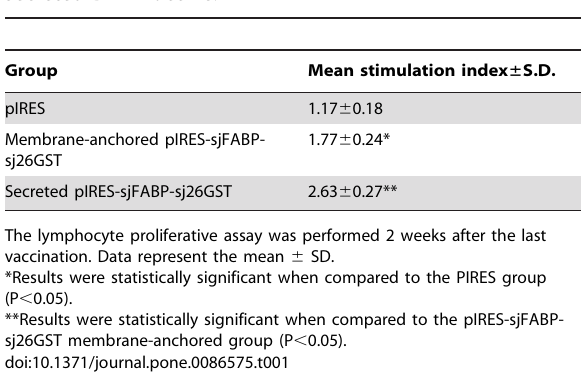
Table 1. Splenocyte proliferative responses in mice immunized with the membrane-anchored vaccine or the secreted DNA